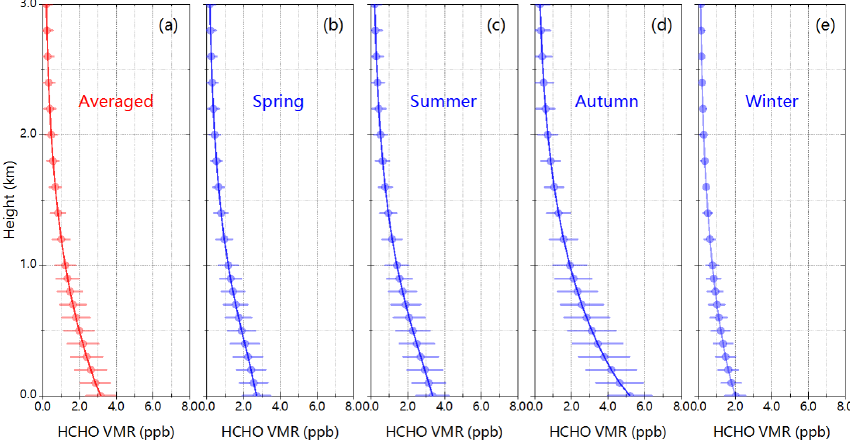
Figure 10. (a) Total-averaged, (b) spring-averaged, (c) summer-averaged, (d) autumn-averaged and (e) winter-averaged HCHO vertical profiles from December 2017 to February 2019 at CAS